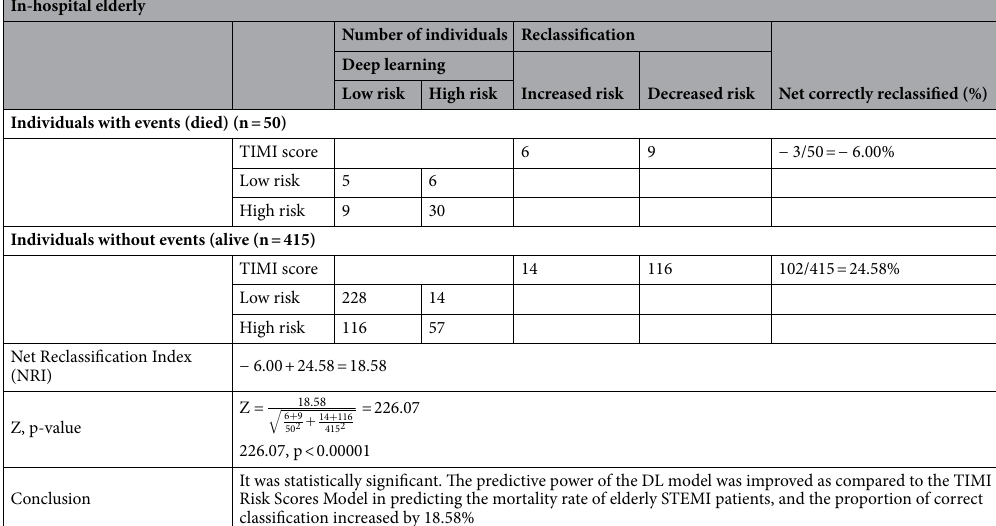
Table 6. NRI analysis for TIMI vs DL (with RF selected variables).